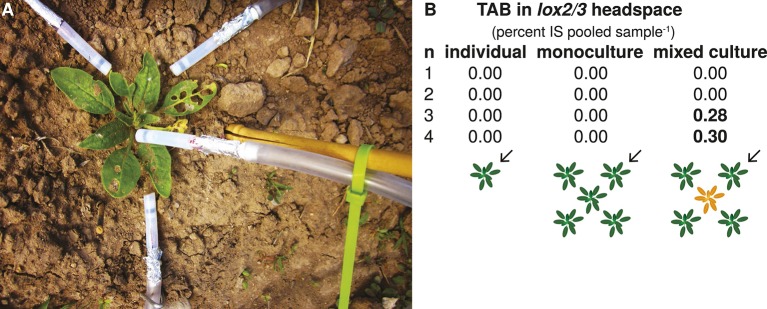
The TPS10 product TAB can be detected in the open headspace around lox2/3 plants in mixed cultures containing a lox2/3xTPS10 plant.(A) An ‘open headspace’ trapping was conducted during season two (May 16th) with rosette-stage individuals and edge plants as shown, using activated charcoal filters shielded from ozone and UV by MnO2-coated copper ozone scrubbers (black strips in Teflon tubes pointed at plant) and aluminum foil, respectively. The headspace was sampled during the day, when sesquiterpenes are most abundant (see Appendix 2). Eluents from all four filters were combined and analyzed using highly sensitive GCxGC-ToF analysis; n = 4 plants. (B) The TPS10 product trans-α-bergamotene (TAB) could be detected in the open headspace of two of four lox2/3 plants at the edges of mixed cultures containing a lox2/3xTPS10 plant, but not in lox2/3 individuals or lox2/3 plants in monocultures. Peak areas were normalized to the internal standard (IS) peak. Arrows indicate the plant that was sampled.